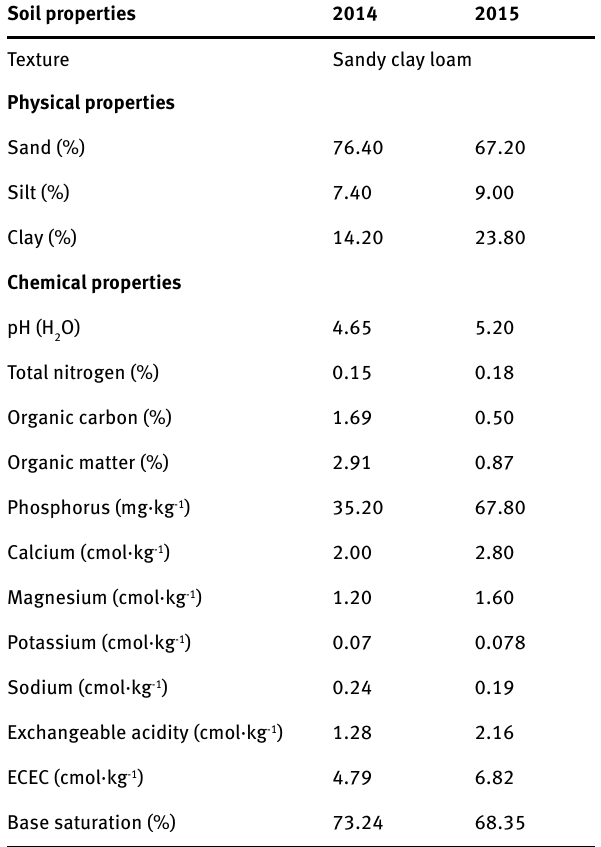
Table 2: Soil physico-chemical properties of experimental sites in